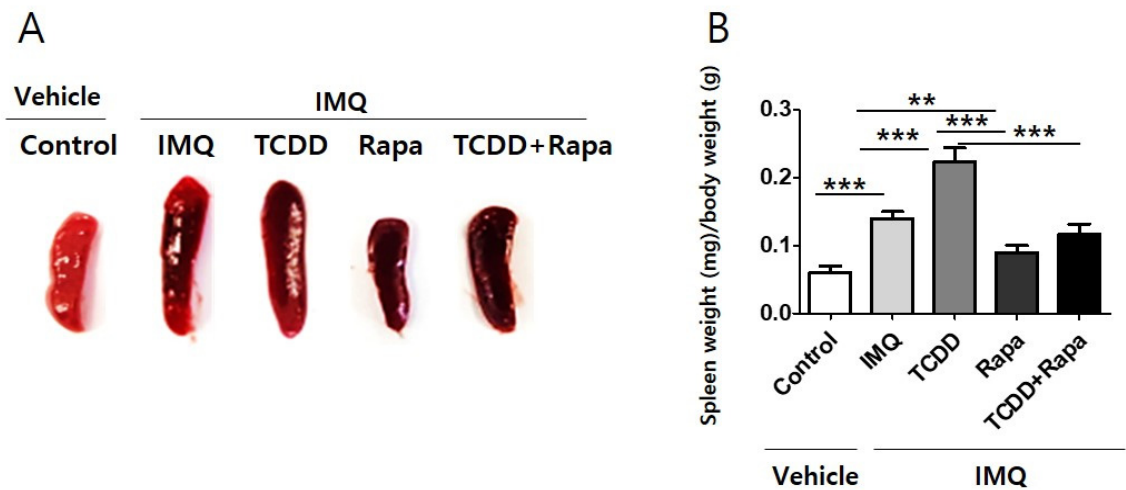
Figure 4. The spleen size and weight of mice from 5 study groups. ( A ) Spleens were prepared from each mouse and weighed. The spleen shown is from 1 representative experiment with n = 5 per treatment group. ( B ) The spleens from mice were isolated and weighed, and the spleen weight index was calculated as organ weight (milligram, mg) per gram (g) of mouse body weight. All data are presented as mean ± standard deviation (SD). Statistical differences were determined by one-way repeated measures analysis of variance (ANOVA) with Dunnett’s test. ** p < 0.01; *** p < 0.001. IMQ: imiquimod, Rapa: rapamycin.